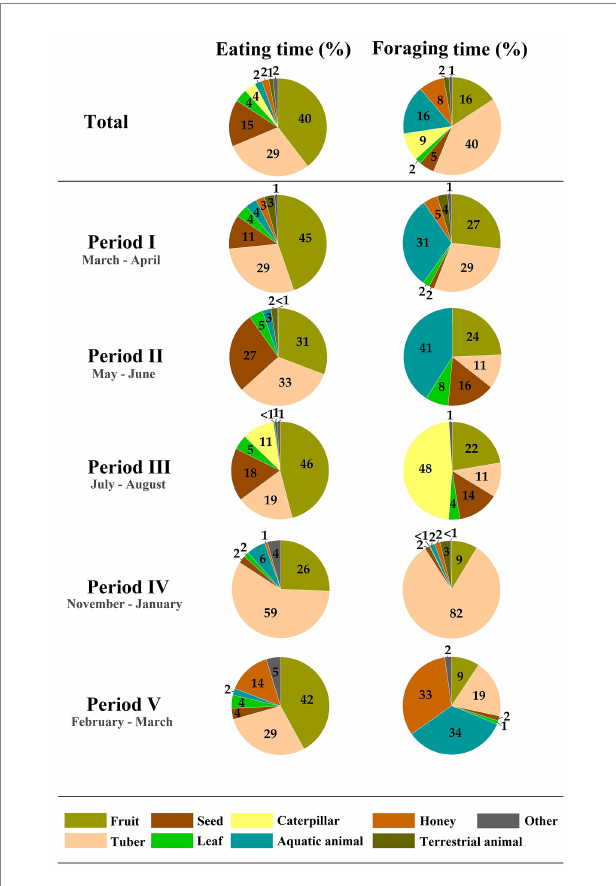
FIGURE 1 Diet composition and foraging activity. Shown are the percentages of time eating and foraging for different food types over the year. The periods visualize the fluctuation throughout the year. Period I to III corresponds with the wet season of 2016 and period IV and V with the dry season of